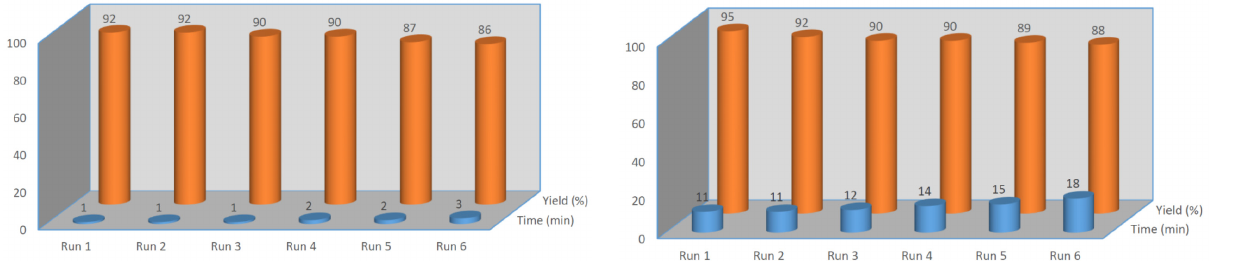
O MNPs in the one-pot reductive 2 4